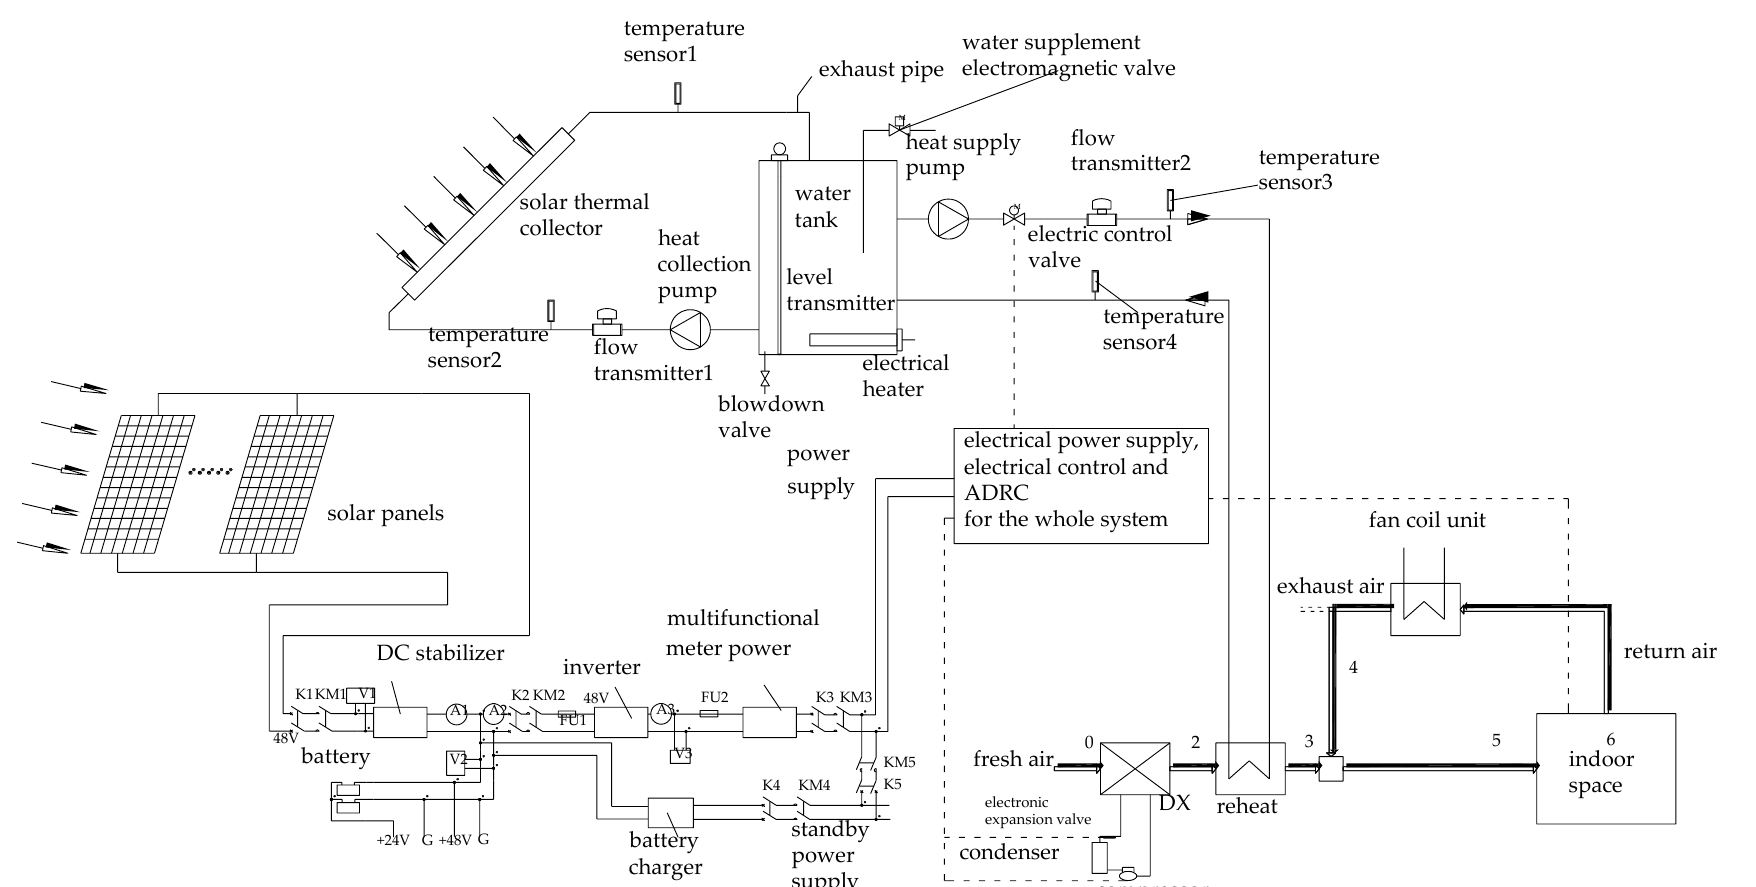
Figure 1. Schematic diagram of the proposed solar dedicated ventilation system based on active disturbance rejection controller (ADRC).